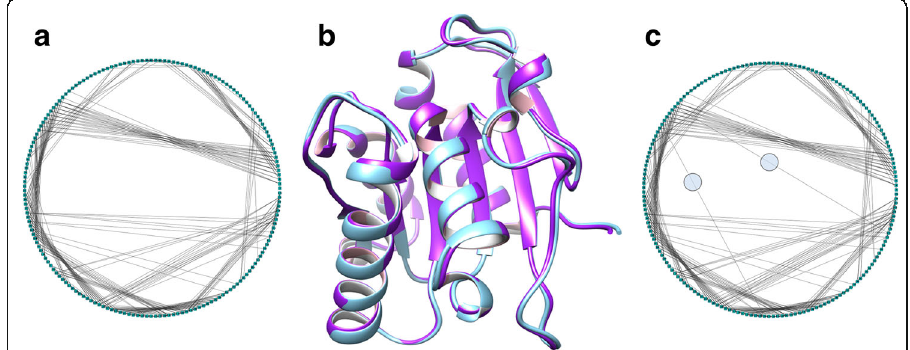
Fig. 3 Network and structural representations of WT and M6: Ring Graph representation of the PCNs of ( a ) WT and ( c ) M6. ( b ) Three-dimensional structural overlap of WT ( blue ) and M6 ( purple ) proteins